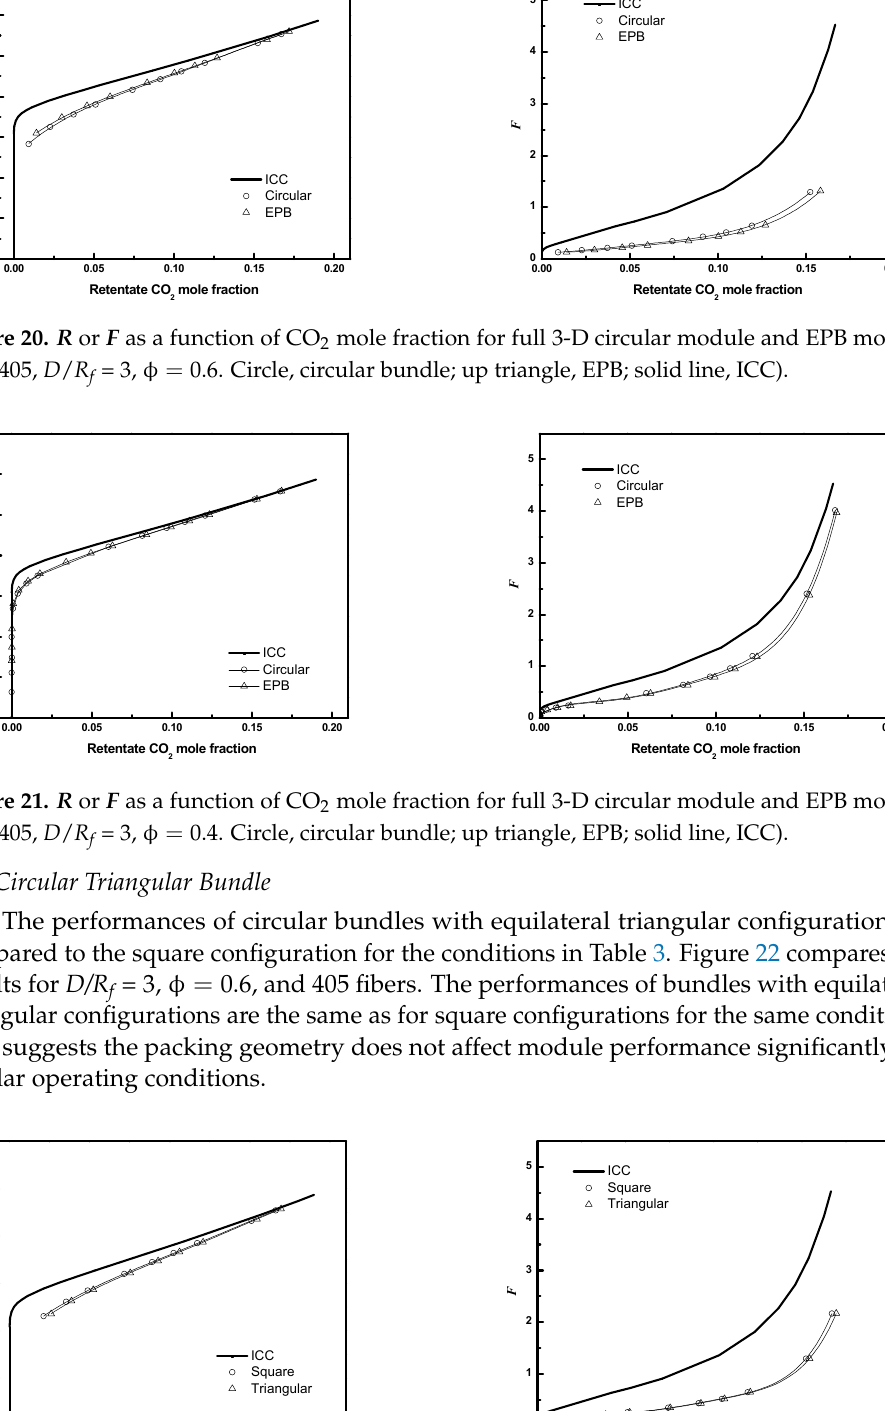
Figure 19. R or F as a function of CO 2 mole fraction for full 3-D circular module and EPB module ( N = 405, D = R f , ɸ = 0 .6. Circle, circular bundle; up triangle, EPB; solid line, ICC).